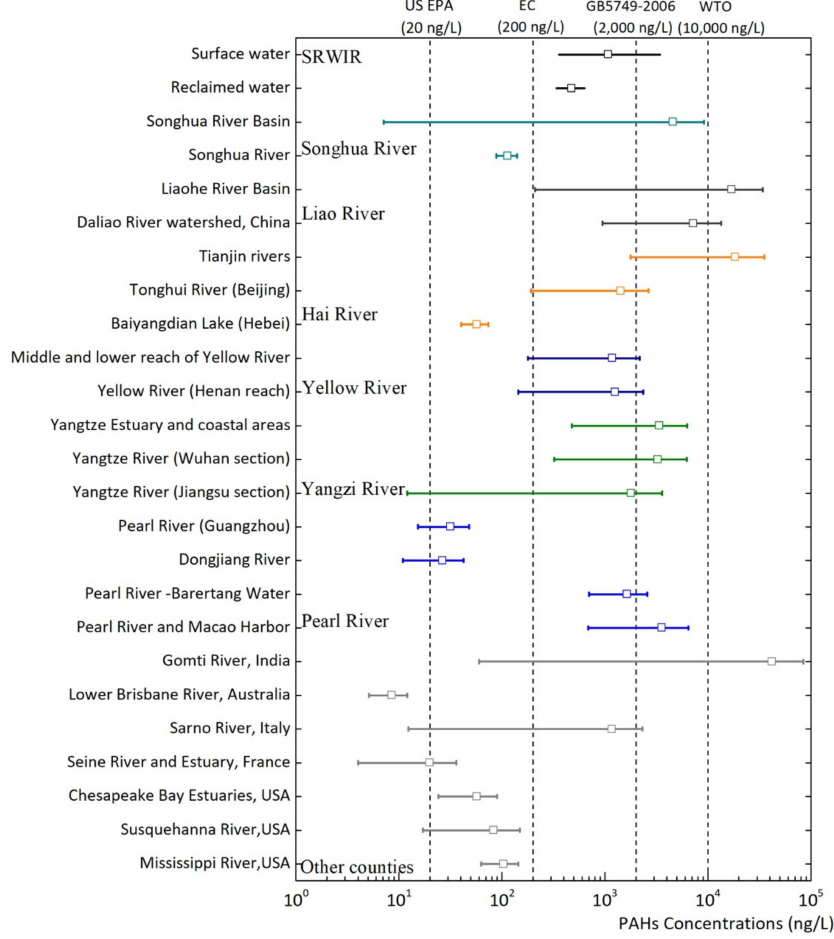
Figure 2. PAHs concentration ranges and values in water as dissolved phase (ng / L) from di ff erent surface water bodies including rivers, estuaries, lake in China and in other countries, modified from [7]. The guideline values adopted by United States Environmental Protection Agency (US EPA), European Union (EU), World Health Organization (WTO) and Chinese standards for drinking water quality